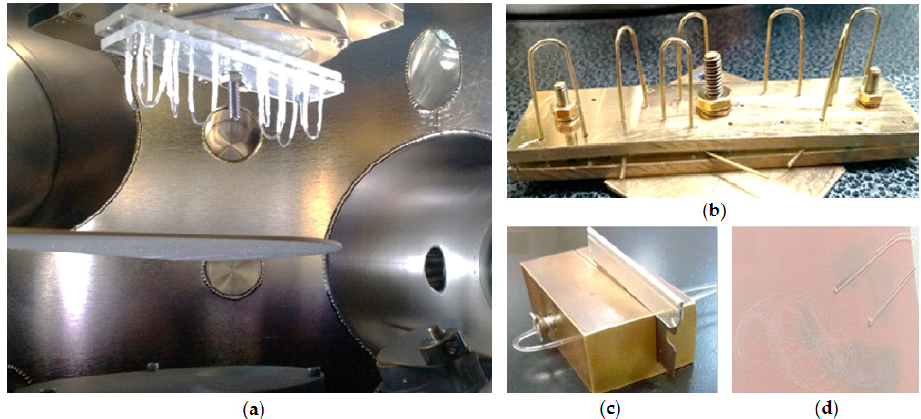
Figure 3. ( a ) Bare U-shaped POF probes installed inside the vacuum sputtering chamber 10 cm above